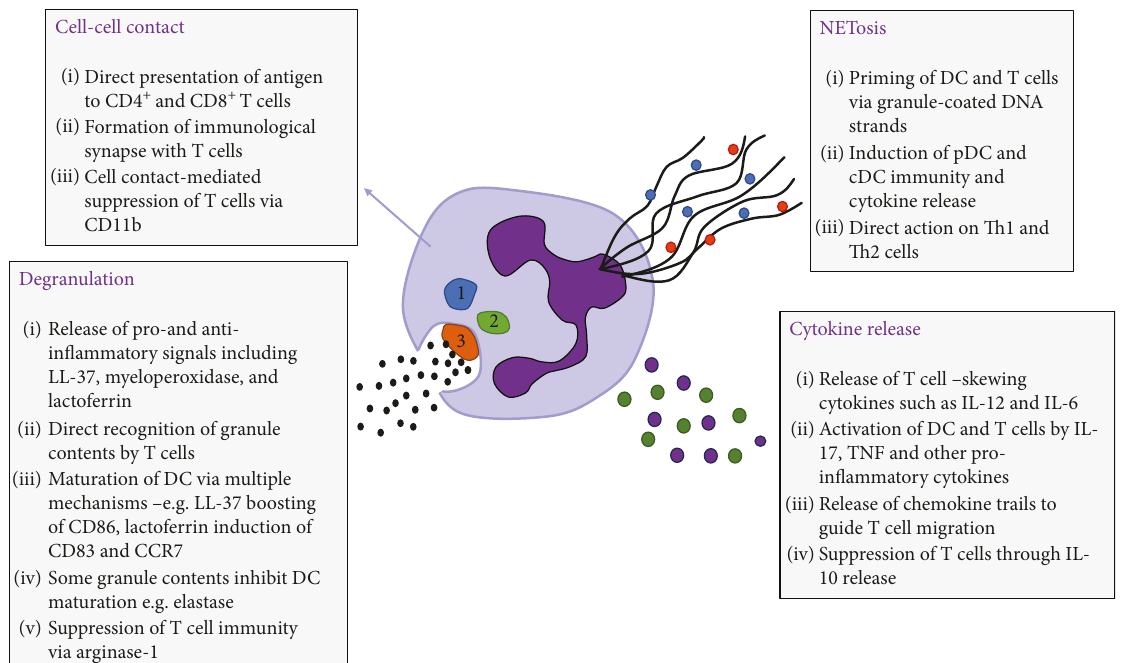
Figure 1: Neutrophils impact T cell immunity through many methods. Neutrophils undergo cell-cell contact, NETosis, degranulation, and cytokine release which a ff ects T cell responses by either activating or suppressing their function. (1) Primary granules, (2) secondary granules, and (3) tertiary